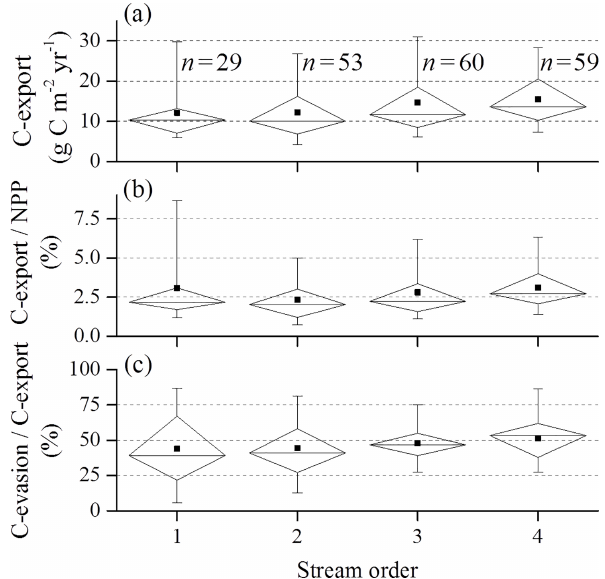
Figure 4. (a) Box plots of C export (sum of evasion and discharge) normalized by catchment area. (b) Box plots of the ratio of the total exported C and terrestrial NPP for different stream orders. (c) Box plots of the fraction of the total exported C which is emitted to the atmosphere from the stream network for each stream order. The boxes demarcate the 25th and 75th percentiles and the whiskers de- marcate the 95% confidence intervals. Median and mean values are marked as horizontal lines and square symbols, respectively. The sample numbers ( n) provided in (a) apply to all